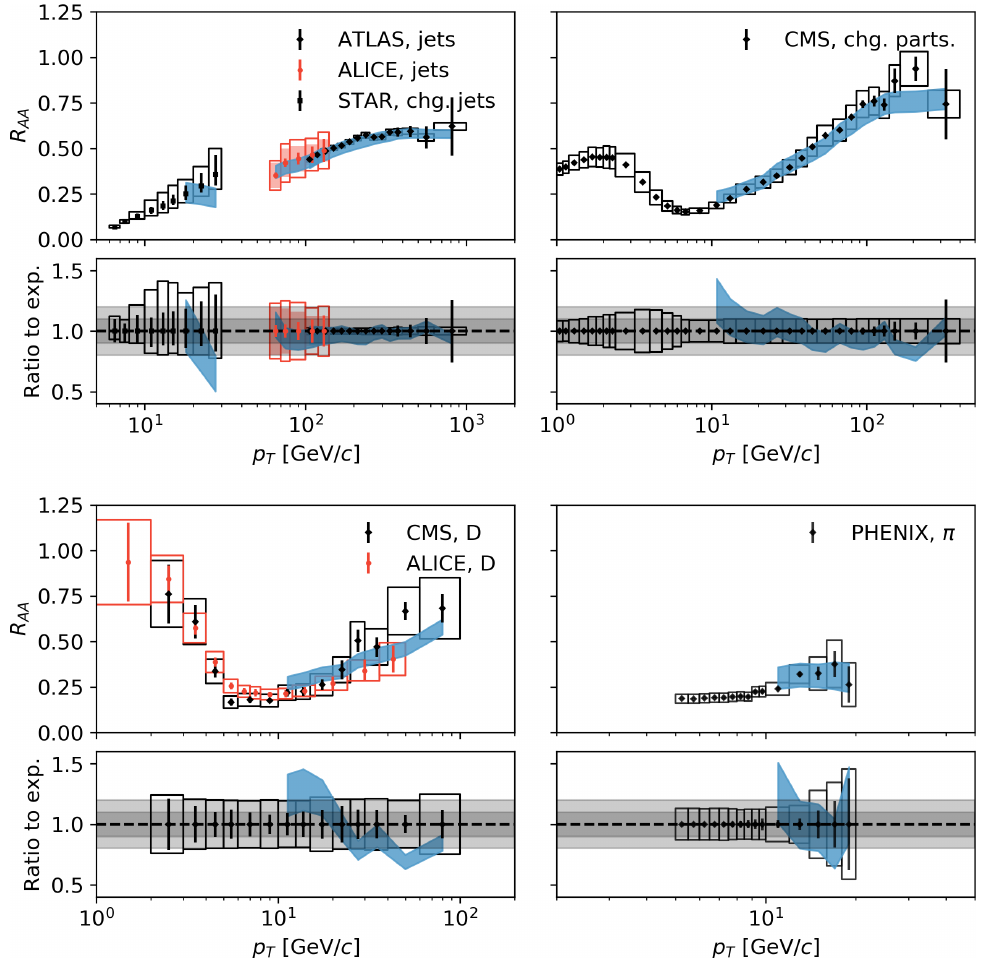
Figure 2 . Emulated calculations of inclusive jet and single hadron suppression after model parame- ters are systematically calibrated to these observables. In each set of plots, the R upper panel, and the ratio to experiment is shown in the lower panel. The blue bands correspond to the 95% credible limit given by the model emulator. The gray bands in the ratio plot denote ± 10% and ± 20% level of discrepancy